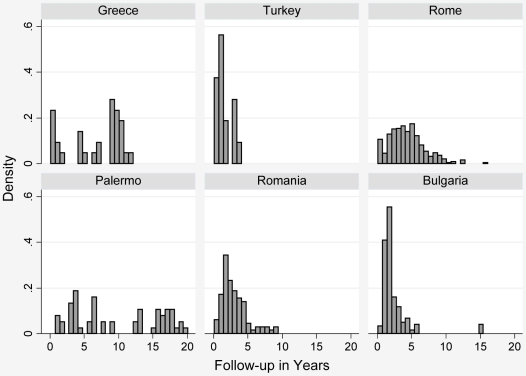
Length of follow-up per centre.